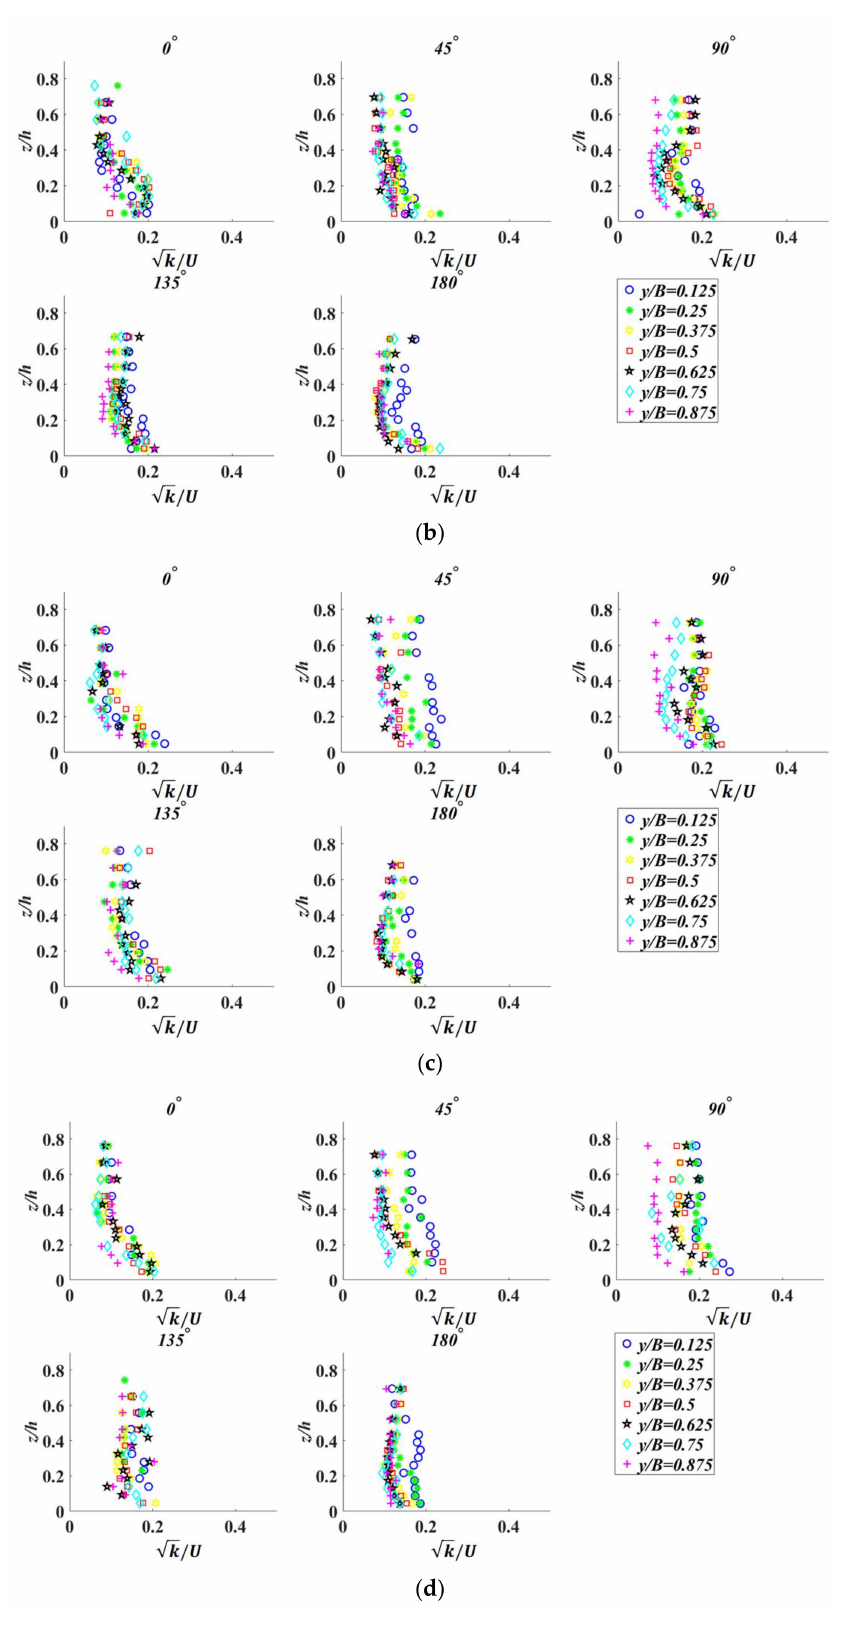
Figure 4. TKE ( k ) profiles for four cases at five cross sections: ( a ) Bare case, ( b ) Small case, ( c ) Middle case, and ( d ) Big case ( Q = 0.030 m 3 s − 1